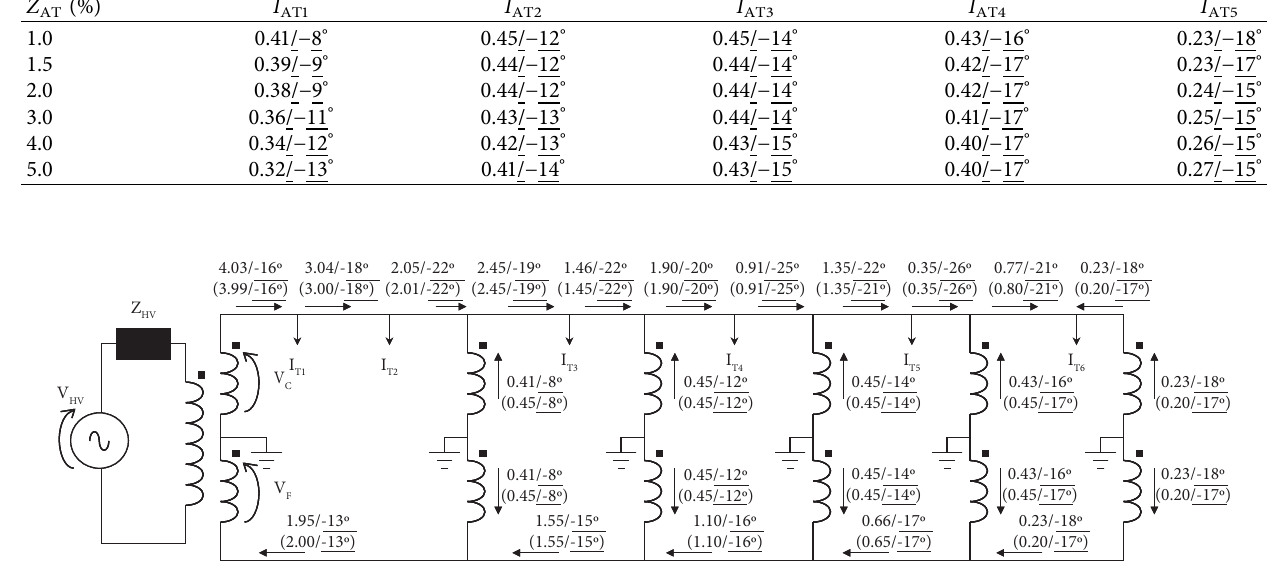
Table 3: Autotransformer currents (in pu) for the example with six trains and real autotransformers. Z AT (%)